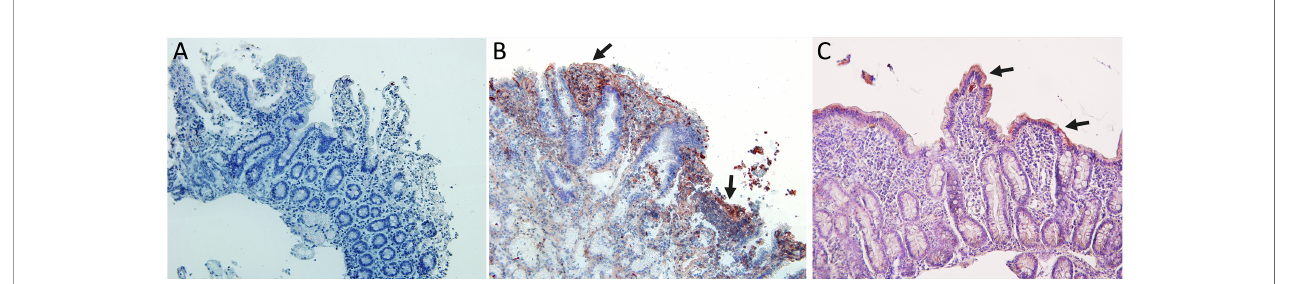
FIGURE 5 | Immunohistochemistry analysis: (A) Negative immunostaining for PD1 in celiac disease patients. (B) Immunostaining for PDL1 in celiac disease patients showing expression in lamina propria cells and in Lieberkhün crypts. (C) Immunostaining for PDL2 in CD patients showing expression in epithelial cells. Magni fi cation 200×. Arrows: cells with immunoreaction.